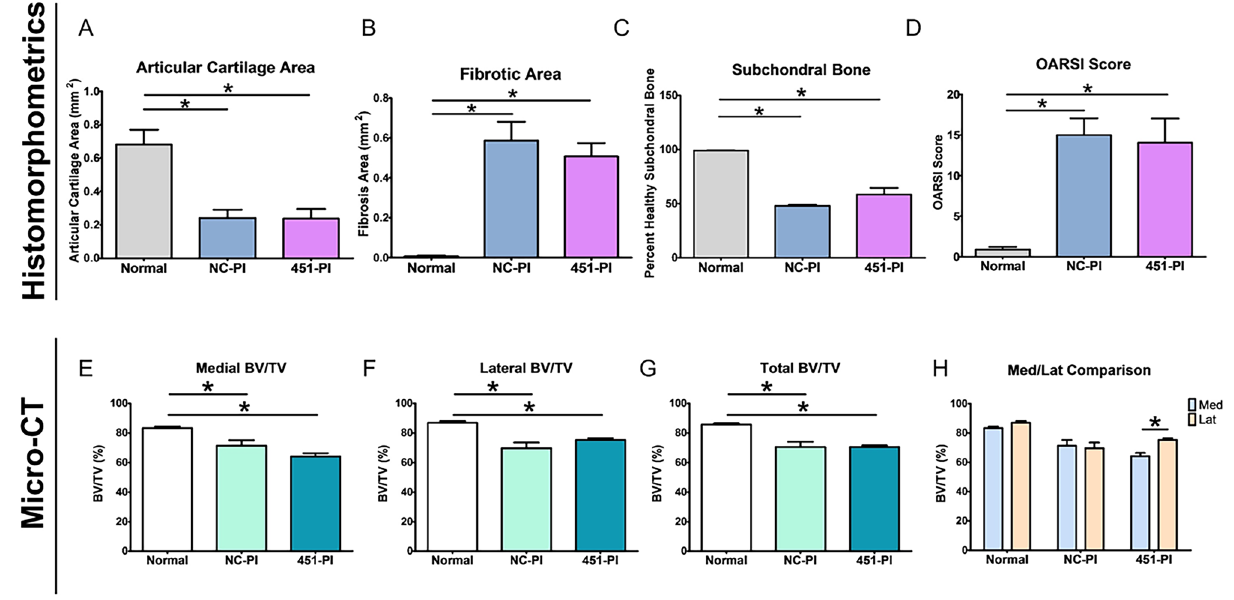
Figure 5. Therapeutic administration of 451-PI does not decrease OA severity. Histomorphometric analysis of articular cartilage area ( A ), fibrotic area ( B ), percent healthy subchondral bone ( C ), and OARSI scoring ( D ). Micro-CT bone volume/total volume (BV/TV) analysis of medial femurs ( E ), lateral femurs ( F ), total (medial + lateral, G ), and the comparison of medial and lateral femurs ( H ). An asterisk indicates statistical significance using an alpha equal to